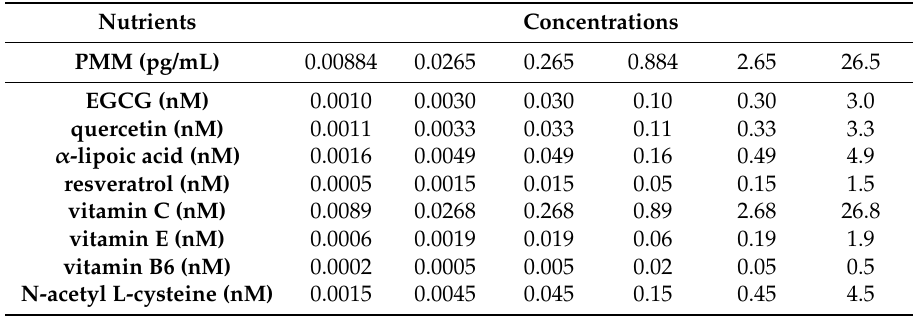
Table 2. PMM concentrations and corresponding contents of the main bioactive components.